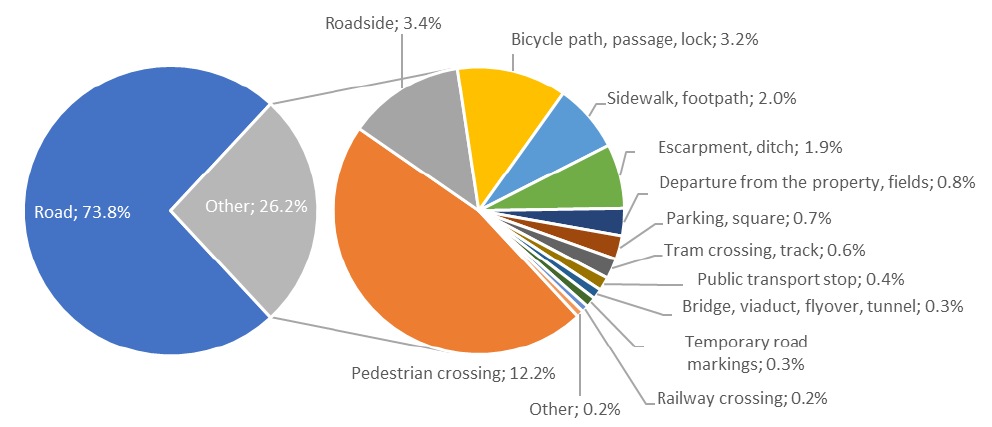
Figure 5. Road accidents in 2019 in Poland by place of their